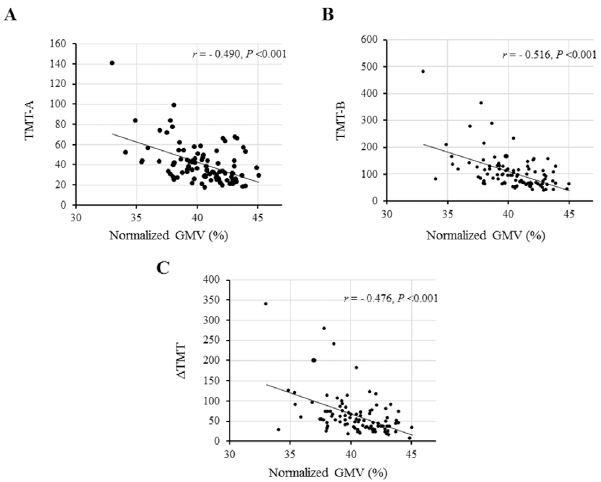
Fig 3. Correlations between normalized gray matter volume (GMV) and the scores (times in seconds) of Trail Making Test (TMT). Significant inverse correlations are found between normalized GMV and each score of TMT-A (A), TMT-B (B), and Δ TMT